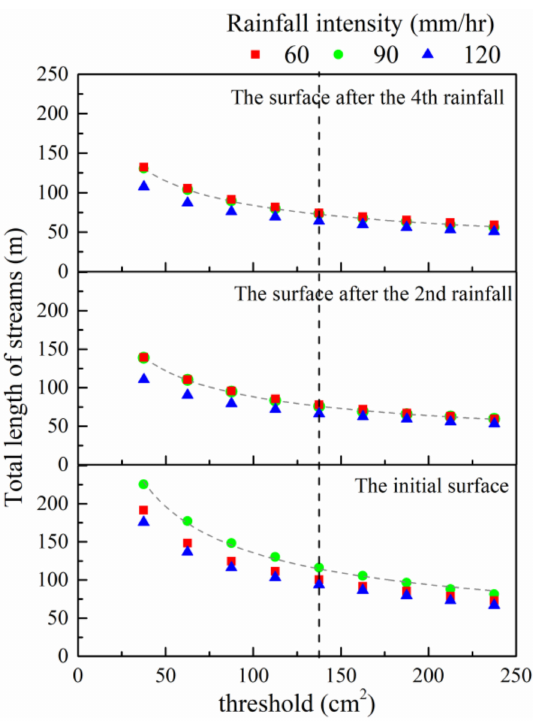
Figure 4. Relationship between critical accumulation areas (threshold) and total stream